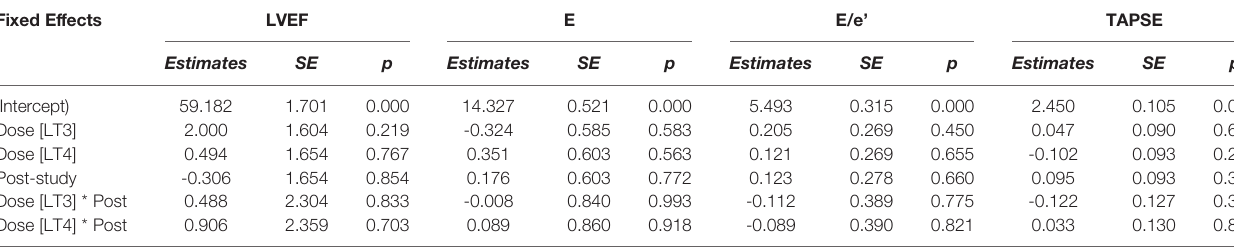
TABLE 5 | Results from linear mixed-effects models for changes in echocardiogram outcomes. Fixed Effects